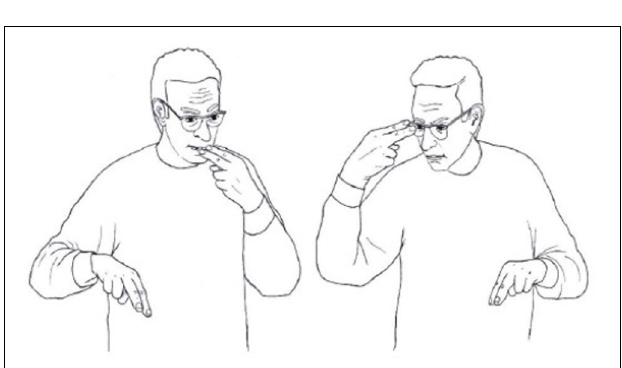
FIGURE 8 | Body parts signal target domain of metaphor in sign language poetry: the member of parliament consumes food and news, by his mouth and eyes (Wim Emerik, ‘Member of